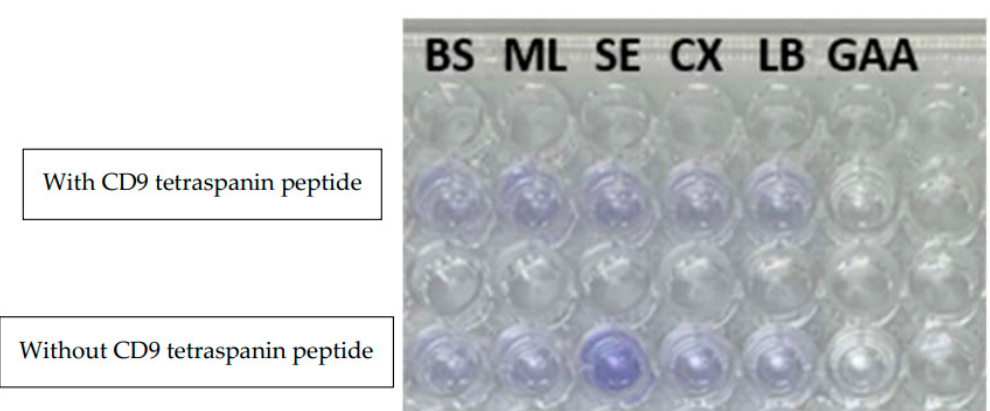
Figure 3. Inhibition of bacterial biofilm by CD9 tetraspanin peptide against axillary microbiota. BS: B. subtilis , ML: M. luteus , SE: S. epidermidis , CX: C. xerosis , LB: Luria-Bertani Broth, GAA: 30% Glacial acetic acid.